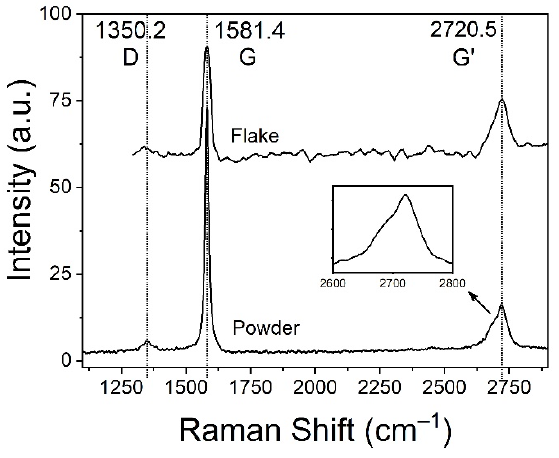
Figure 3. Raman scattering spectra for the as-received GNP and its D, G and G’ bands. Top spectrum was taken from a representative individual GNP flake, and bottom spectrum from GNP powder.